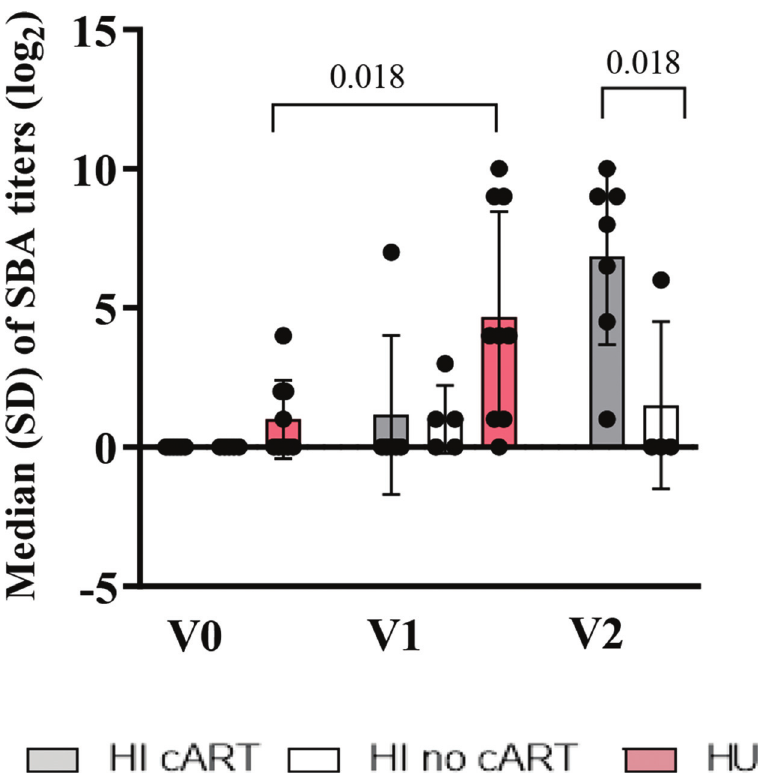
Figure S2 - Median titers of bactericidal antibodies against MenC strains in vaccinated HI patients from the cARTor no-cART groups and HU children; before (V0), one-two months after the first dose (V1), and after the second dose (V2) of vaccine (MenC-CRM 197 ). HIV- uninfected (HU) received only one vaccine injection.